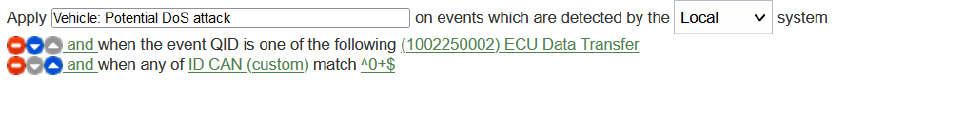
Figure 10. DoS rule in QRadar.